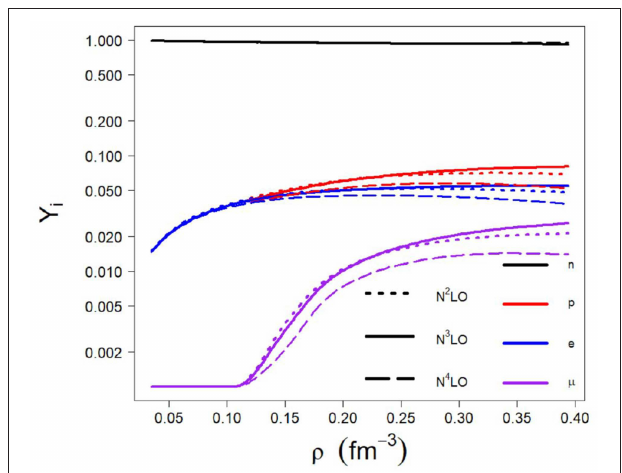
FIGURE 10 | Fractions of neutrons, protons, electrons, and muons as a function of density at the indicated orders for 3 = 450 MeV.